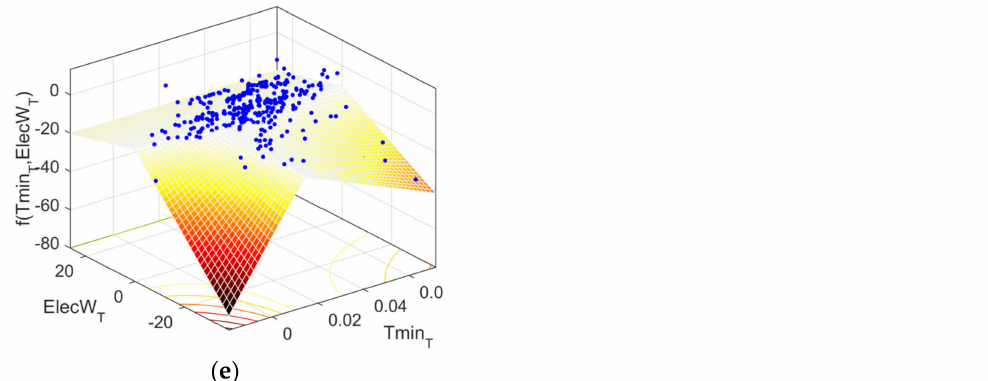
Figure 8. Influence of interactive variables ( a ) P and Rs, ( b ) P and Rsb, ( c ) is NDVI and Rs, ( d ) is ElecW and P, and ( e ) ElecW and Tmin identified by MARS on the TWS trend. Scatter plot is the relationship for the trend of interactive variables and TWS trend calculated by GRACE. The T subscript refers to the slope of variables.